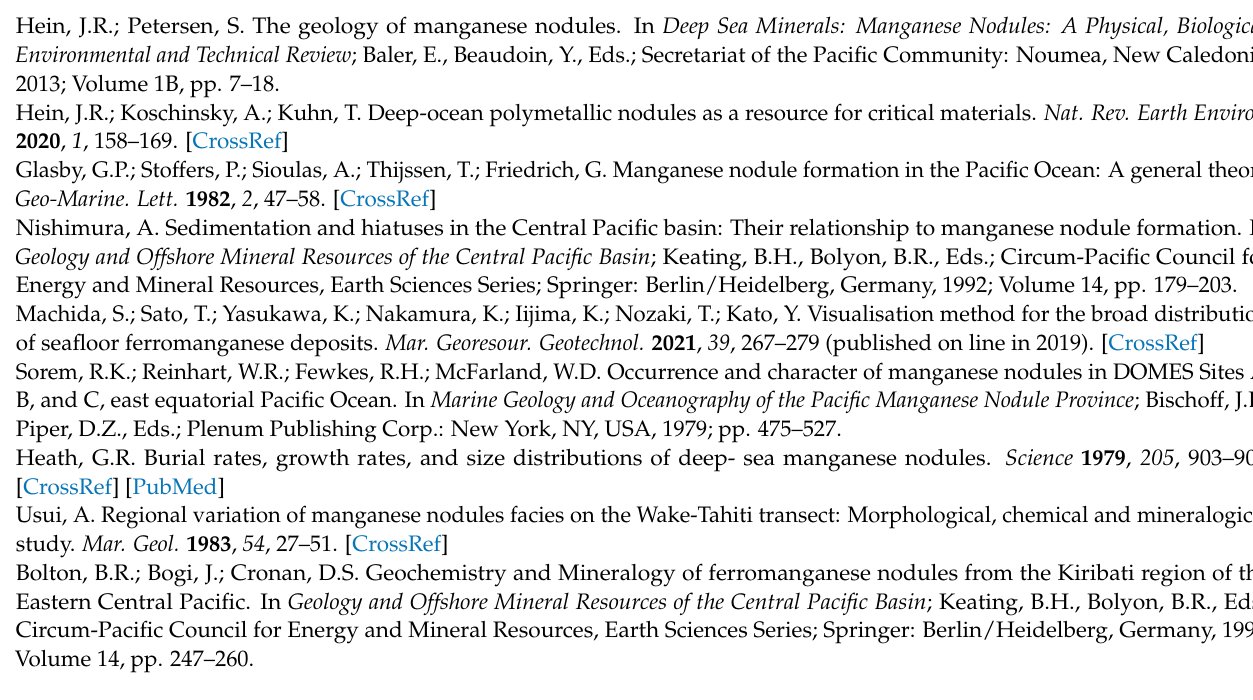
Figure S5: Merged multichemical feature map of the samples analyzed in this study collected